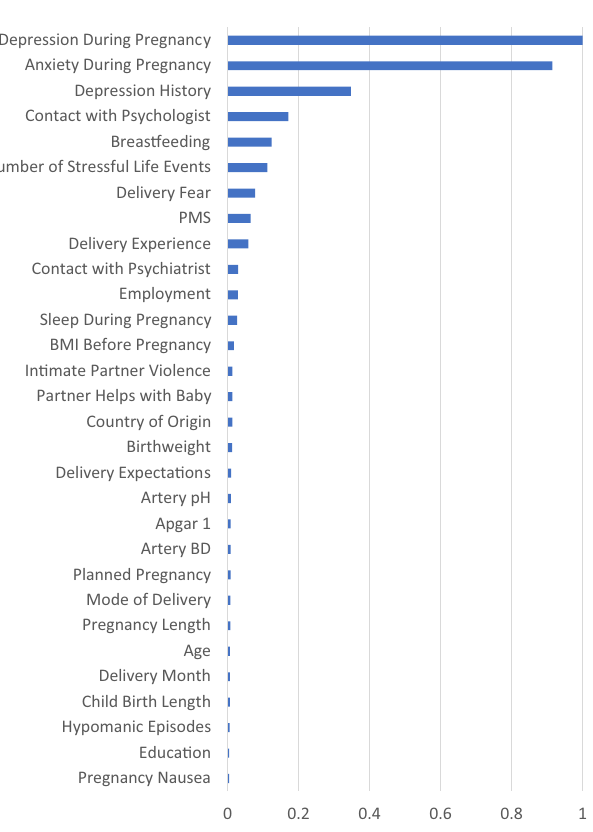
Figure 6. Ranked importance of the assessed background, medical history and pregnancy variables for all women (n = 4277) using Extremely Randomized Trees (XRT) models. The top 25% of the variables are reported . The x-axis represents the relative contribution of the corresponding variable to the classification